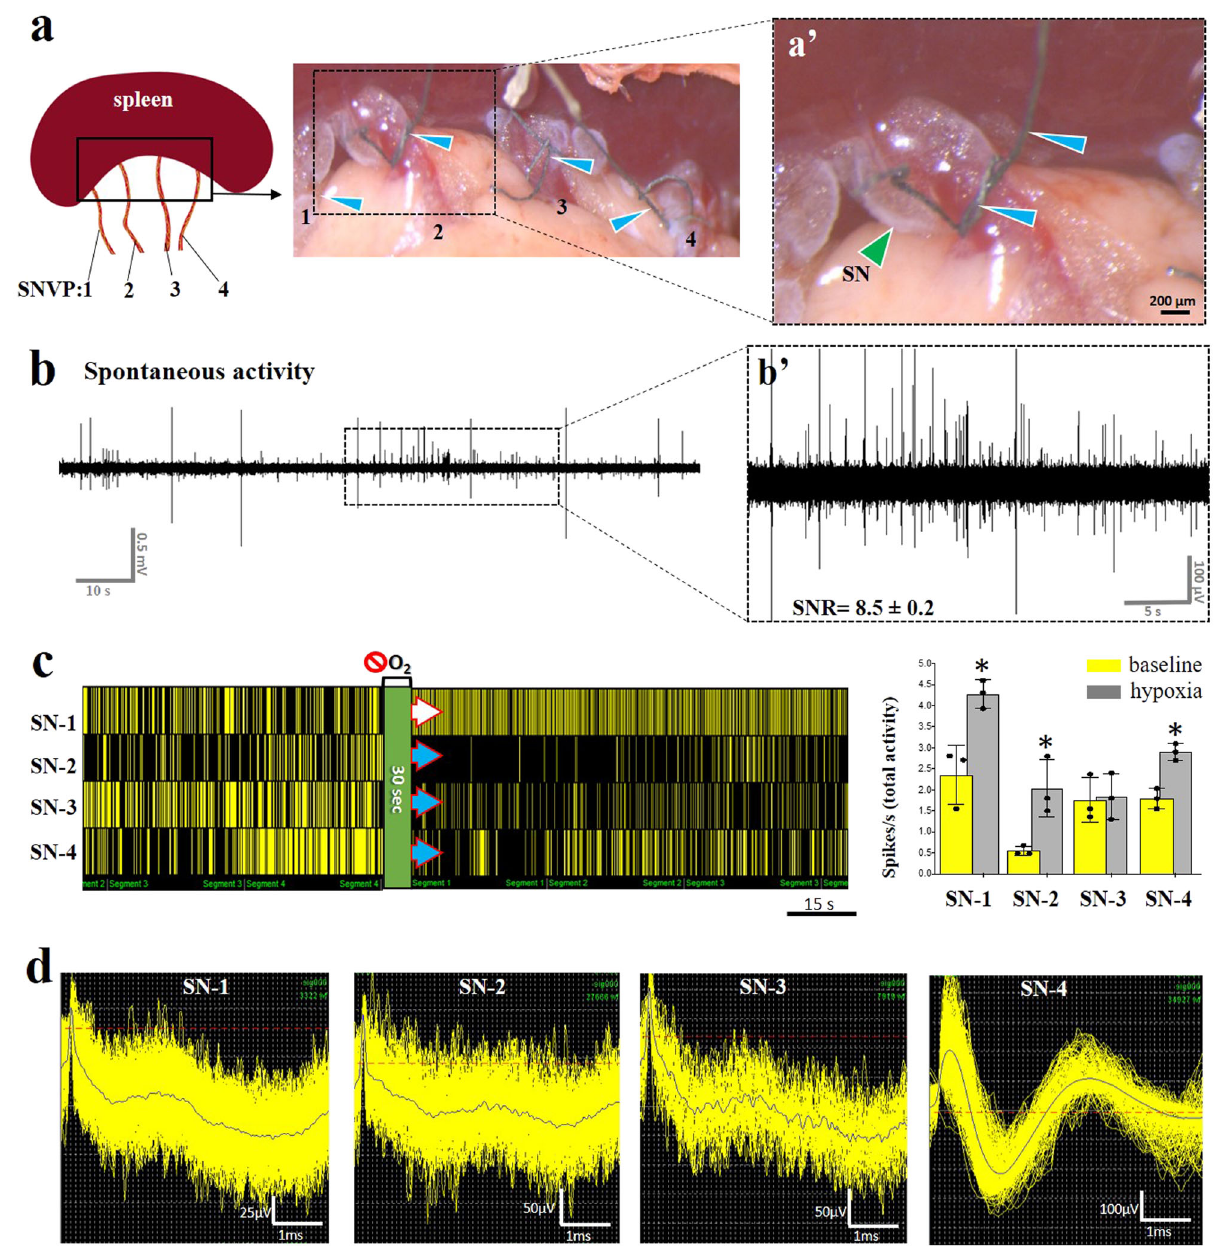
Fig. 4 Sutrode recording of SNVP terminal branches revealed differential response to Oxygen deprivation. a Schematic and pictures of the SNVP branches (1 – 4; apical to basal) interfaced with sutrodes (blue arrowheads in a and a ´), tied around the SNVP ( a ’ ), green arrowhead points out a SN branch. b Representative raw spontaneous recording of neural activity from SN-1 (signal to noise ratio, SNR = 8.5 ± 0.2 peak to peak, b ´. c Simultaneous raster plots from a representative waveform from the four SN branches showing differential patterns of activity before and after Oxygen deprivation (green strip) of identi fi ed CNAPs waveforms, on the right, overlapped graphics of total activity, comparing baseline (yellow), and at 1 min after Oxygen deprivation (gray) for all the SN, n = 3), whiskers represent SD, * p < 0.05. d The spontaneous activity increased in SN-1 (white arrow in c ) but decreased in SN-2 – 4 (blue arrows in c ). SN splenic nerve, SNVP splenic neurovascular plexus, SNR signal to noise ratio, CNAPs compound nerve action